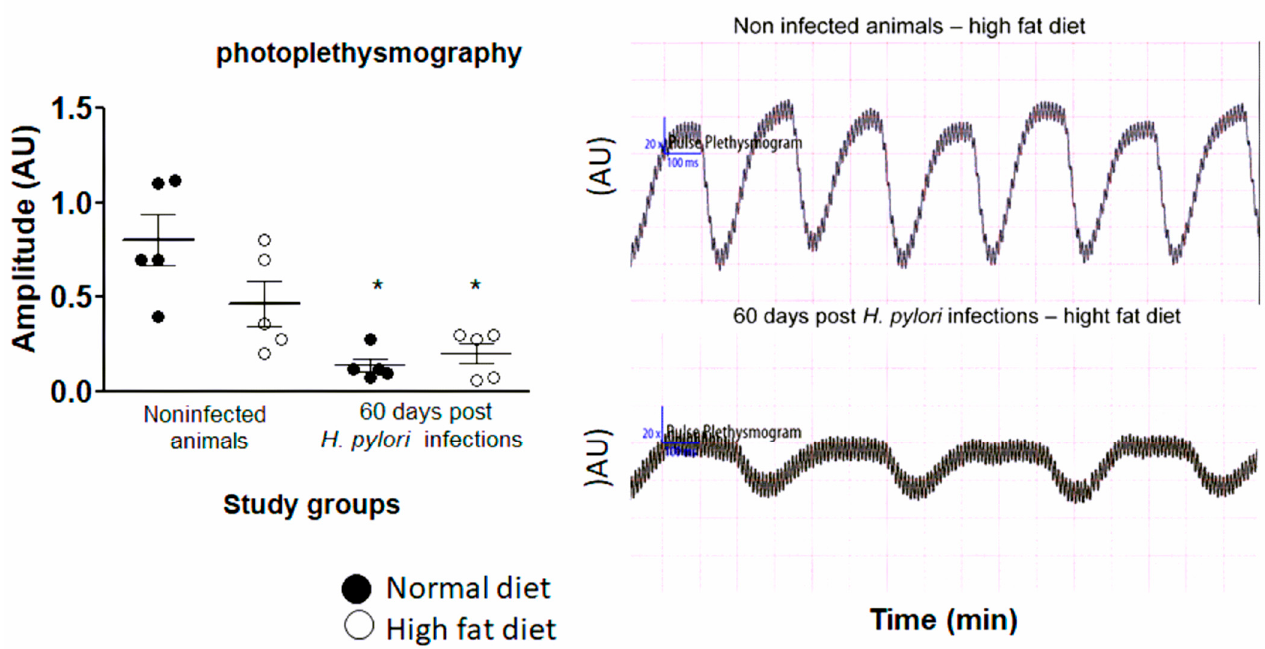
Figure 4. Photoplethysmography analysis of the arteries of uninfected and H. pylori -infected animals, at 60 days from inoculation, exposed to normal chow or an experimental high-fat diet. Five animals per group were examined. The results are presented as the mean values of the amplitudes (AU) ± SD. Statistical analysis was performed with the nonparametric Kruskal–Wallis test. Statistical significance, * p < 0.05, was obtained for H. pylori -infected animals vs. the control animals.